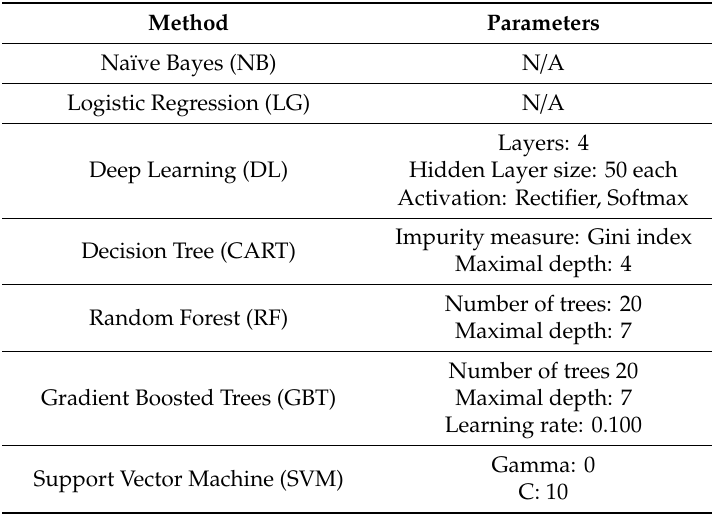
Table 5. Classification models